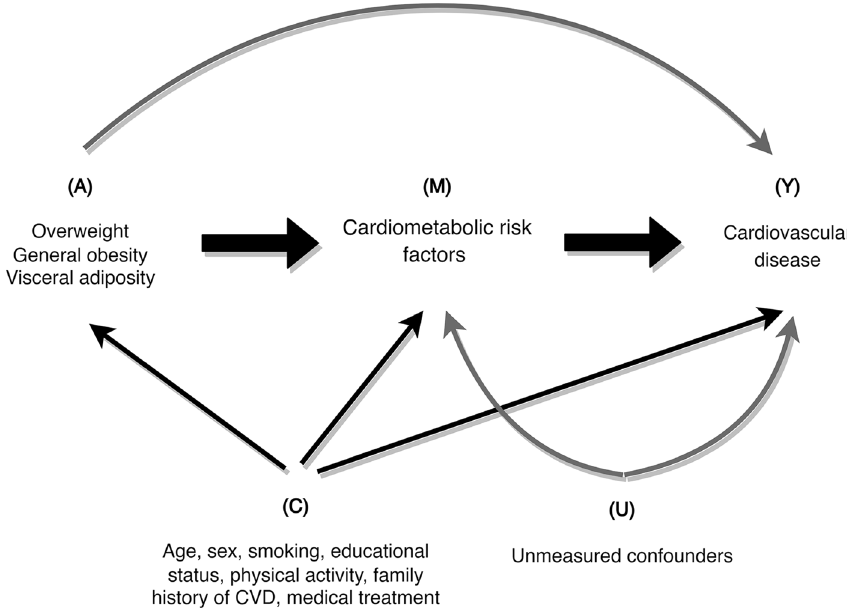
Figure 1. The relationship between exposures (A), mediators (M), outcome (Y), and measured confounders (C) as well unmeasured confounders